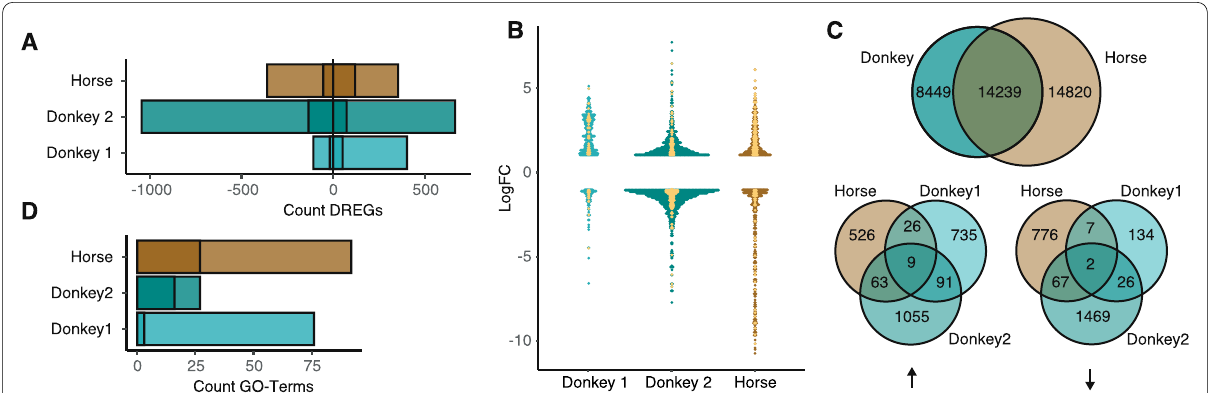
Fig. 3 Analysis of deregulated genes. The threshold for deregulated genes (DREG) was set at a fold change above or below 2 or p -value (FDR < 0.05) and reads per kilobase million mapped reads (RPKM) of at least 1. A Number of up- and down-regulated genes per sample. = Saturated area corresponds to immune-associated genes. B Overview of DREGs within each sample. Yellow dots indicate immune-associated genes. C Overlap of genes between the donkey and horse reference genome (upper Venn diagram). Overlap of all up- and down-regulated genes (indicated by